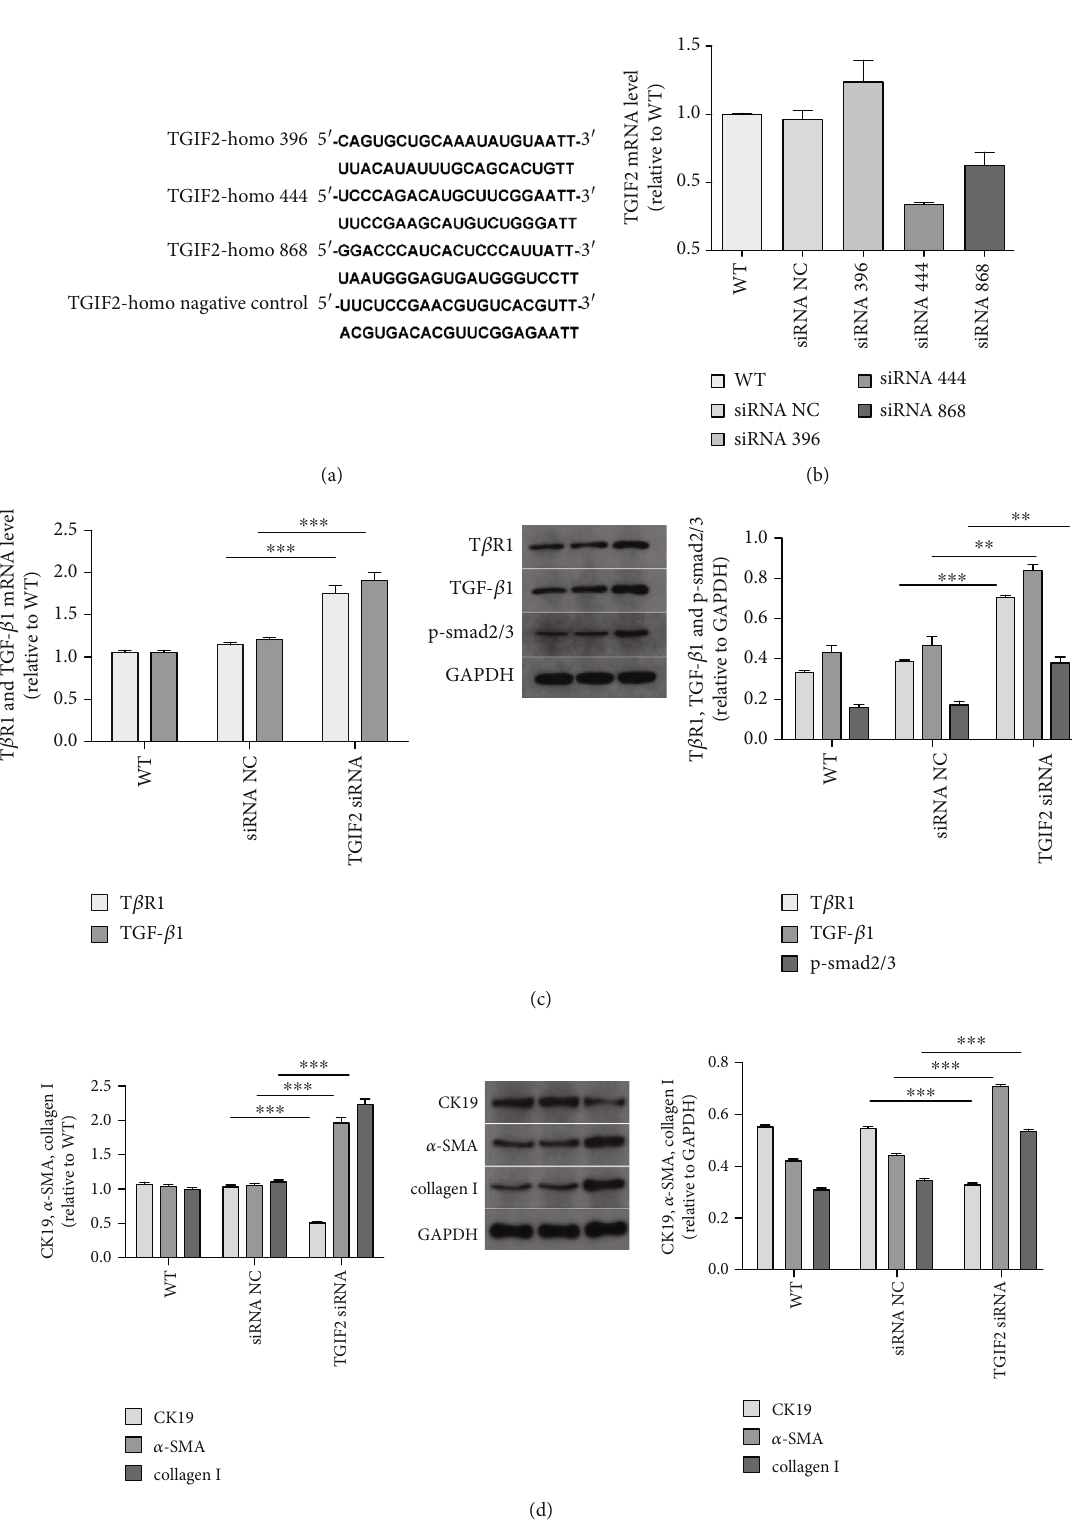
Figure 2: TGIF2 interacted with the TGF- β 1/smad pathway. (a) Sequences of three TGIF2 siRNAs and negative control. (b) TGIF2 mRNA level after transfected by siRNAs. (c) T β R1 and TGF- β 1 mRNA levels (for T β R1, TGIF2 siRNA vs. NC, P < 0 : 0001 ∗∗∗ ; for TGF- β 1, TGIF2 siRNA vs. siRNA NC, P < 0 : 0001 ∗∗∗ ). Relative T β R1, TGF- β 1, and p-smad2/3 protein expressions (for T β R1, TGIF2 siRNA vs. NC, P < 0 : 0001 ∗∗∗ ; for TGF- β 1, TGIF2 siRNA vs. NC, P = 0 : 0047 ∗∗ ; and for p-smad2/3, TGIF2 siRNA vs. NC, P = 0 : 0039 ∗∗ ). (d) CK19, α -SMA, and collagen I mRNA levels between TGIF2 siRNA and NC ( P < 0 : 0001 ∗∗∗ , P < 0 : 0001 ∗∗∗ , and P < 0 : 0001 ∗∗∗ ). Relative CK19, α -SMA, and collagen I protein expressions between TGIF2 siRNA and NC ( P < 0 : 0001 ∗∗∗ , P = 0 : 0002 ∗∗∗ , and P = 0 : 0004 ∗∗∗